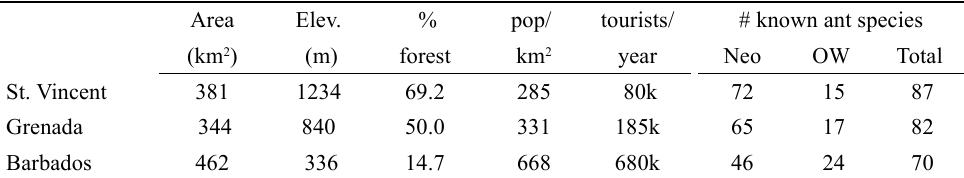
Table 1 . Ant species richness known from St. Vincent and the neighboring islands of Barbados (Wetterer et al., 2016) and Grenada (Wetterer et al., 2019). Elev. = maximum elevation. Neo = Neotropical